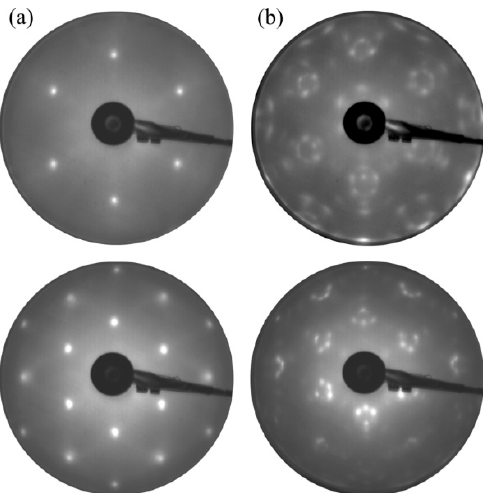
Figure 5. Low-energy electron diffraction (LEED) patterns for the GaN(0001)-(1 × 1) structure. Image ( a ) is attributed to flat well-ordered surfaces; ( b ) shows the presence of facets. Images were taken with an electron beam of 90 (upper) and 155 eV (bottom).